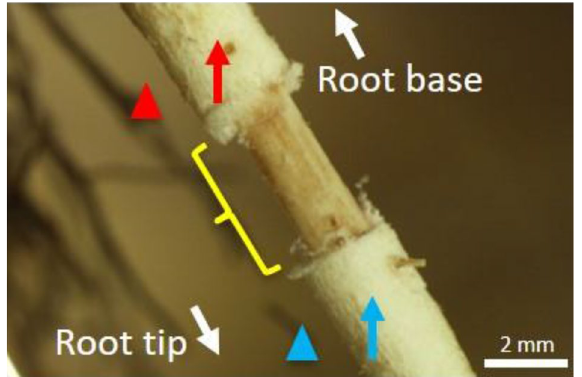
Figure 4. Measurement of oxygen concentrations in remaining portions of secondary aerenchyma in adventitious roots after secondary aerenchyma removal. Adventitious roots were used for measurement of changes of pO 2 in primary aerenchyma, secondary aerenchyma, and rhizosphere after 150 days of treatment in agar media. Yellow parentheses show where the secondary aerenchyma was removed from the adventitious root. Oxygen concentration was measured in the secondary aerenchyma (red and blue arrow) above and below where the secondary aerenchyma had been removed. Oxygen concentration was measured at the root surface (rhizosphere) above and below where the secondary aerenchyma had been removed from the root (red and blue arrowheads). White arrows indicate the orientation of the